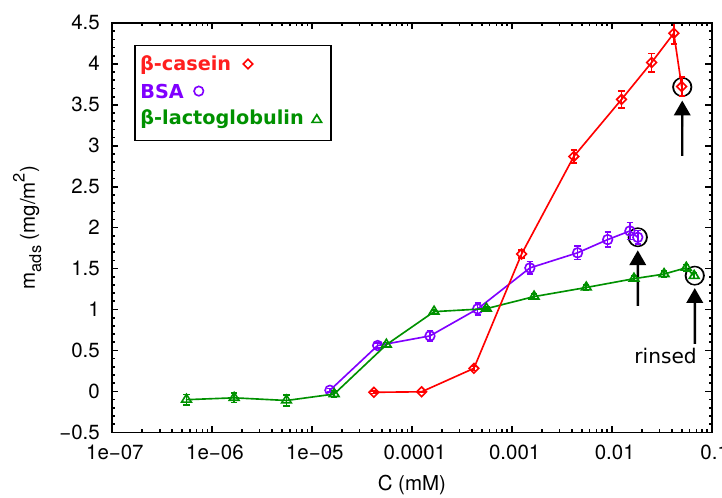
Figure 7. Adsorption isotherms obtained from QCM-D measurements for protein adsorption onto PS hydrophobic surfaces and pH 6 ( β -lactoglobulin and BSA) or pH 7 ( β -casein). The last data point was obtained after rinsing with protein-free buffer solution, as indicated in the